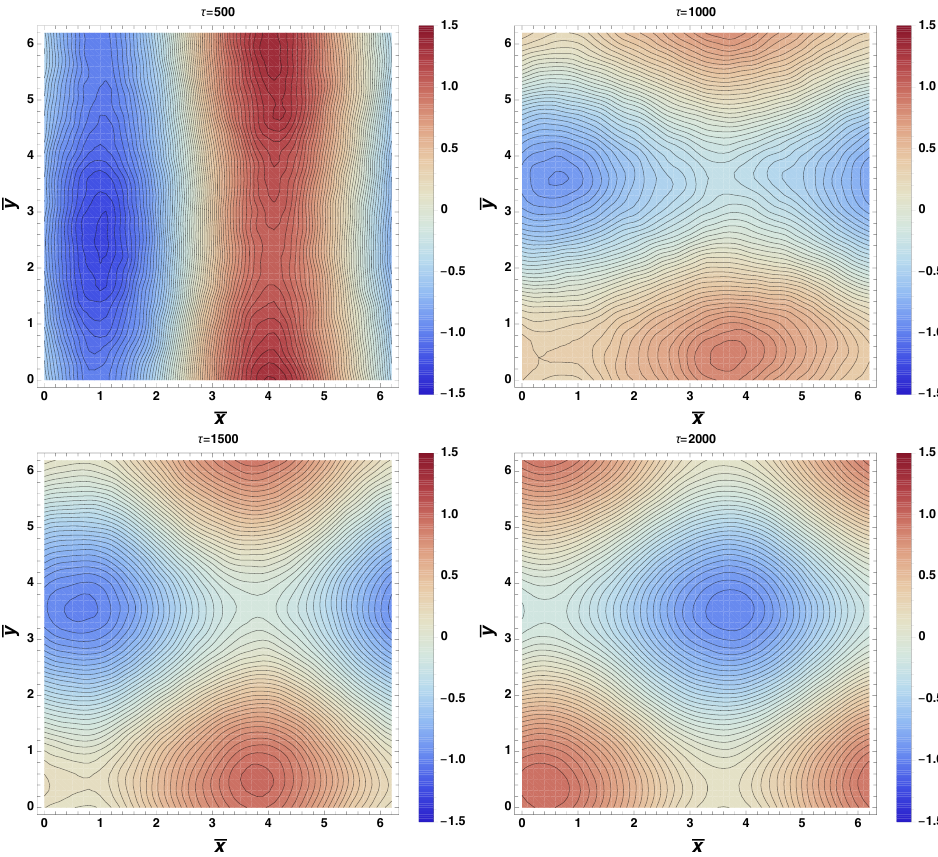
Figure 10. Case A2—viscous. Plots of constant Φ ( ¯ x , ¯ y ) (arbitrary units) at fixed